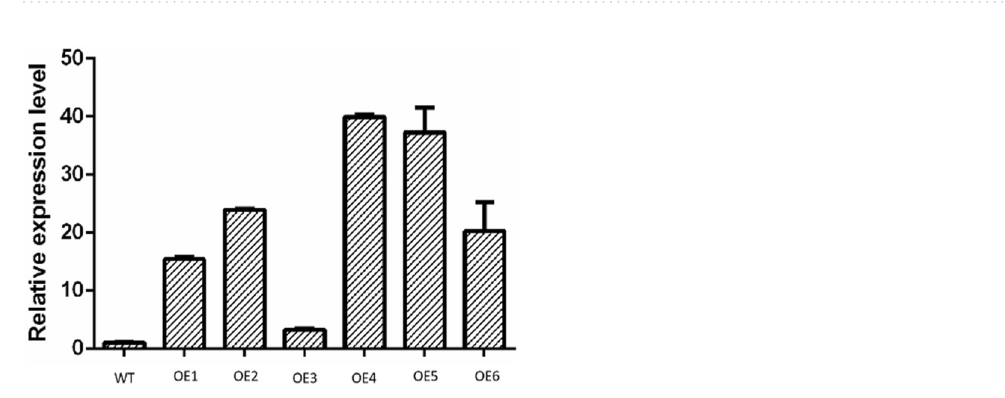
Figure 8. PCR detection of p1302 -LoHDZ2 in transgenic tobacco. M: 2000 bp DNA molecular marker; 1: negative control; 2: water; 3: positive control; 4–10: transgenic strains.